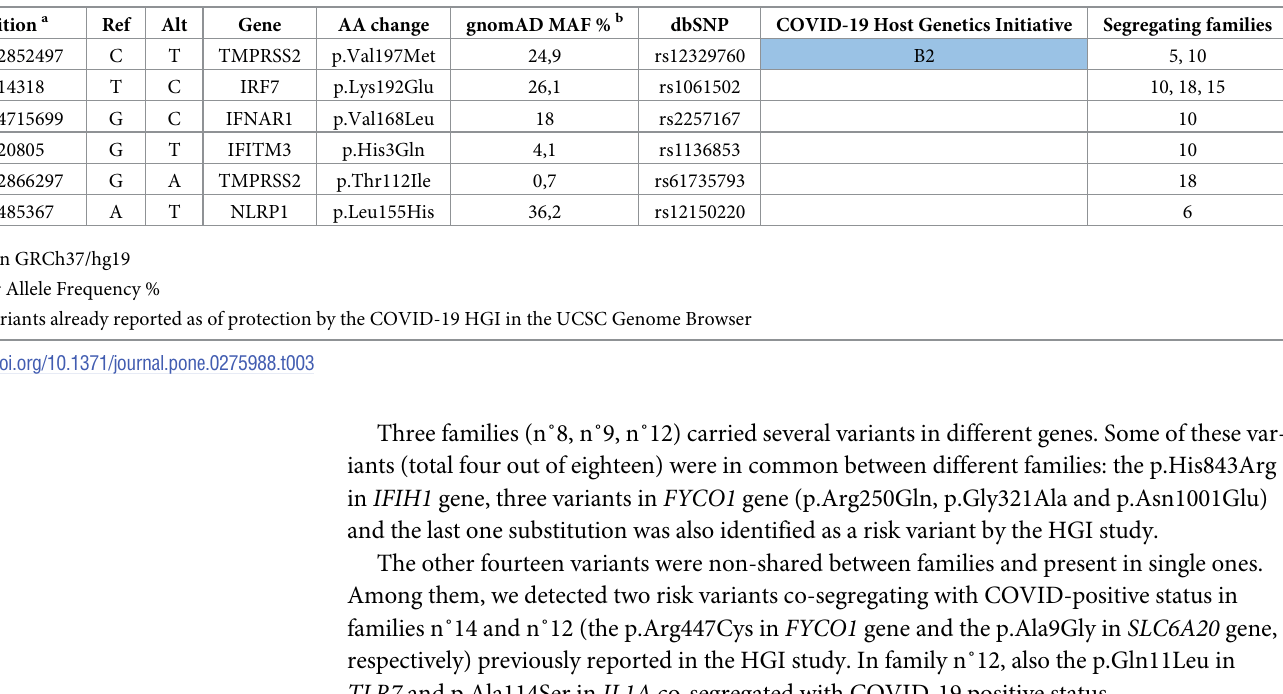
Table 3. Familial segregation of protective variants in families with negative SARS-CoV-2 test. Position